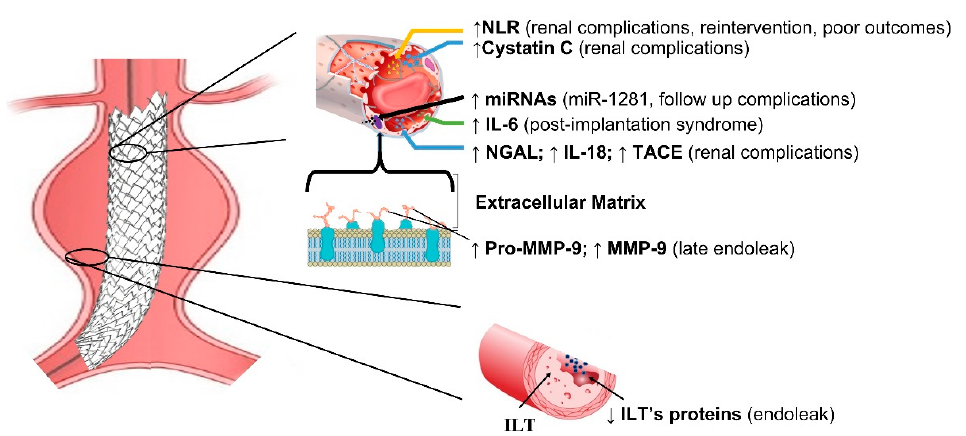
Figure 1. Schematic representation of main biomarkers in EVAR. NLR = Neutrophil–to–Lymphocyte ratio; IL-6 = interleukin 6; IL-18 = interleukin 18; NGAL = Neutrophil gelatin-associated lipocalin; TACE = tumor necrosis factor – α converting enzyme; ILT = intraluminal thrombus; ILT’s proteins = intraluminal thrombus proteins; MMP-9 = matrix metalloproteinase and tissue inhibitors; miRNAs = micro RNA.